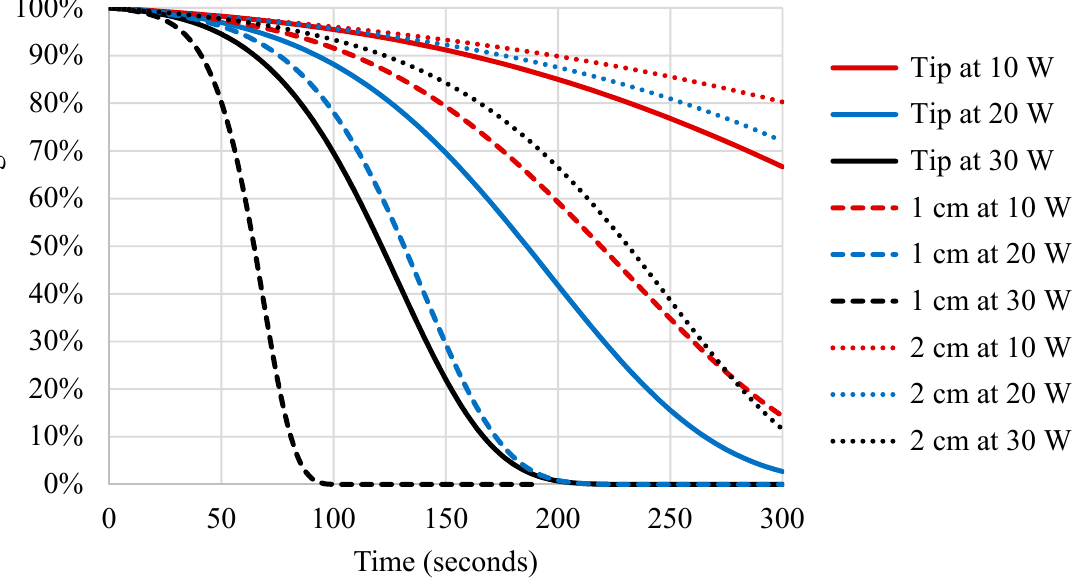
Figure 10. Comparison of cell survival percentage for input power levels of 10, 20, and 30 W (Cases 1, 2, and 5 where the coolant flowrates were 1 g/s) at three locations: at the tip (point 1), at 1 cm (point 20), and 2 cm (point 25).